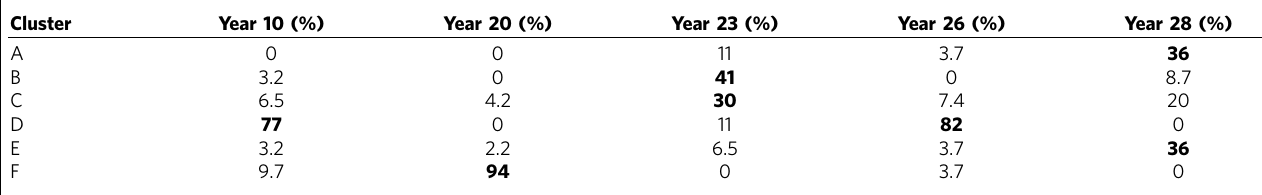
Table 1 | Percentage of single cells in each expression cluster by date.